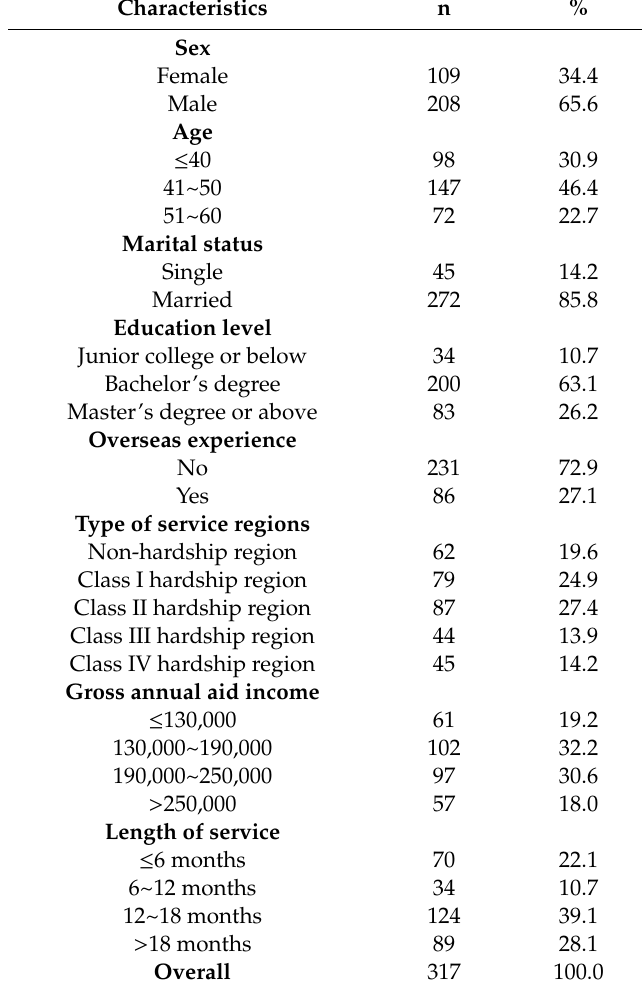
Table 1. Characteristics of the study population (n = 317).